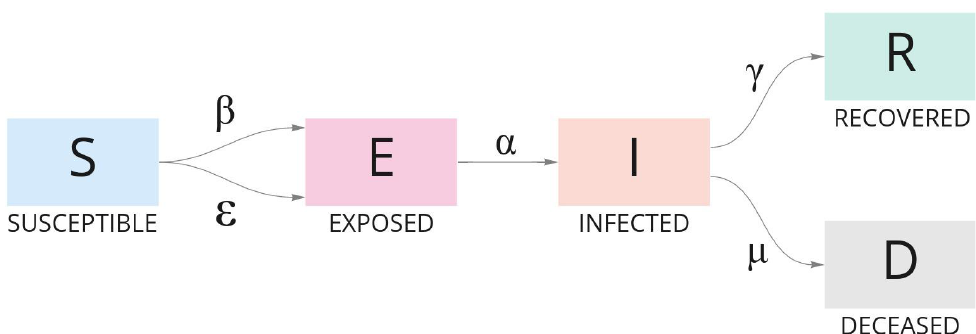
Figure 5. The evolution of individuals in a population during the course of an outbreak according to the SEIRD model. Each group of individuals is defined by an ODE and categorized as Susceptible, Exposed, Infected, Recovered, and